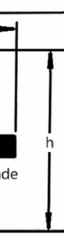
Figure 2. Schematic of a Rushton turbine.